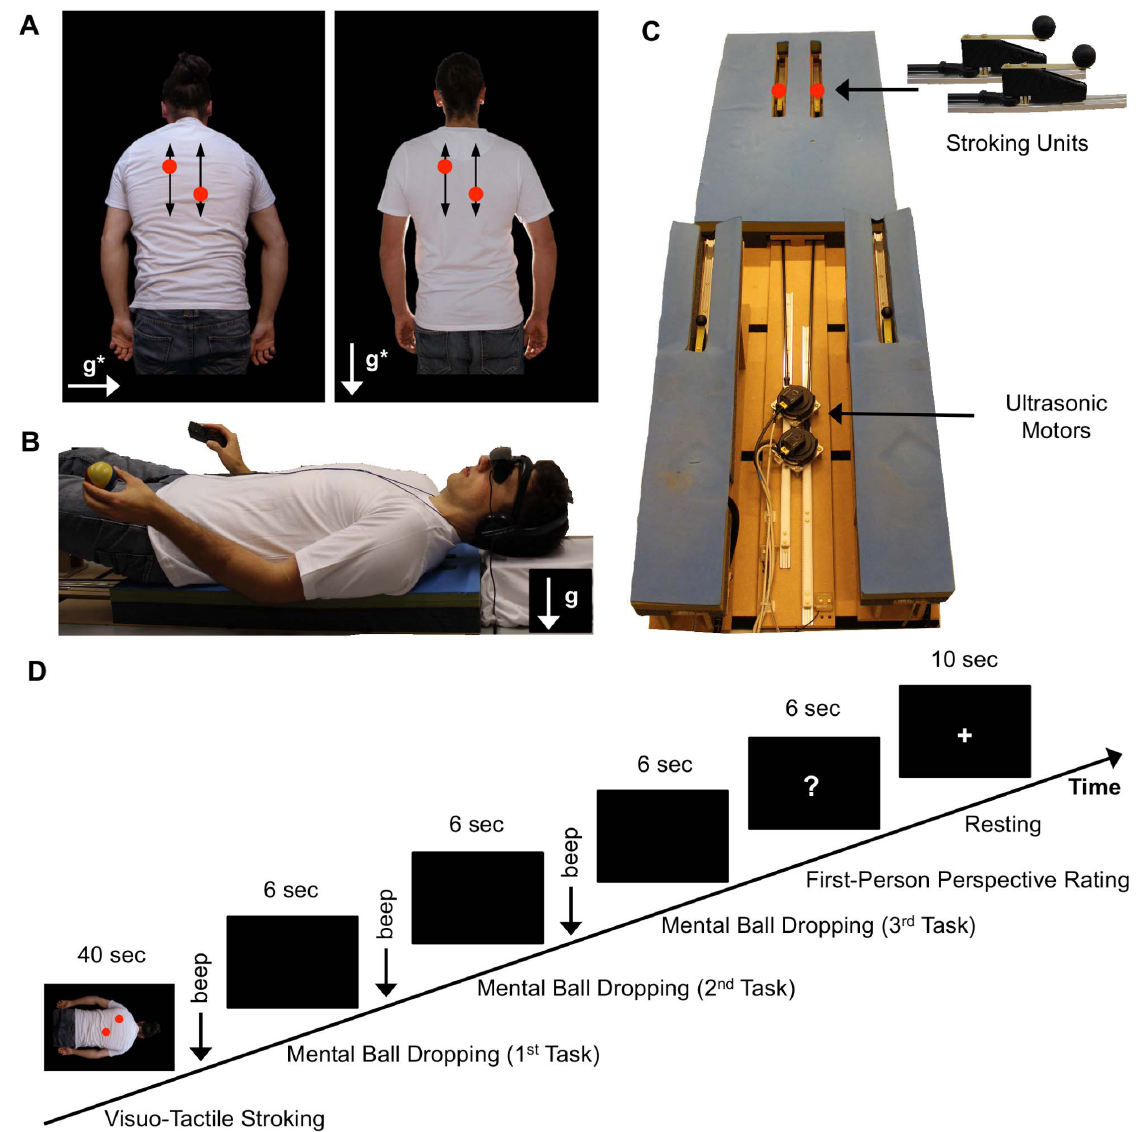
Figure 1. Experimental stimuli, setup, and procedure. (A) Visual stimuli showing a virtual body in prone posture from an elevated downward perspective used during the strong Visuo-Vestibular Conflict condition (left panel) and the same body standing used during the weak Visuo- Vestibular Conflict condition (right panel). Visual implied direction of gravity in each panel is indicated by a white arrow and ‘g*’ label. Visual stroking was presented by red dots (trajectory indicated by black arrows). (B) Participant lying supine, equipped with a ball to facilitate mental imagery during Mental Ball Dropping task, a button response device, and a head-mounted display. Direction of veridical vertical is indicated by a white arrow and ‘g’ label. (C) Robotic device used for tactile stimulation of the participants’ back. Stroking units (in red color) were actuated by ultrasonic motors. (D) Sequence of events in an experimental trial.